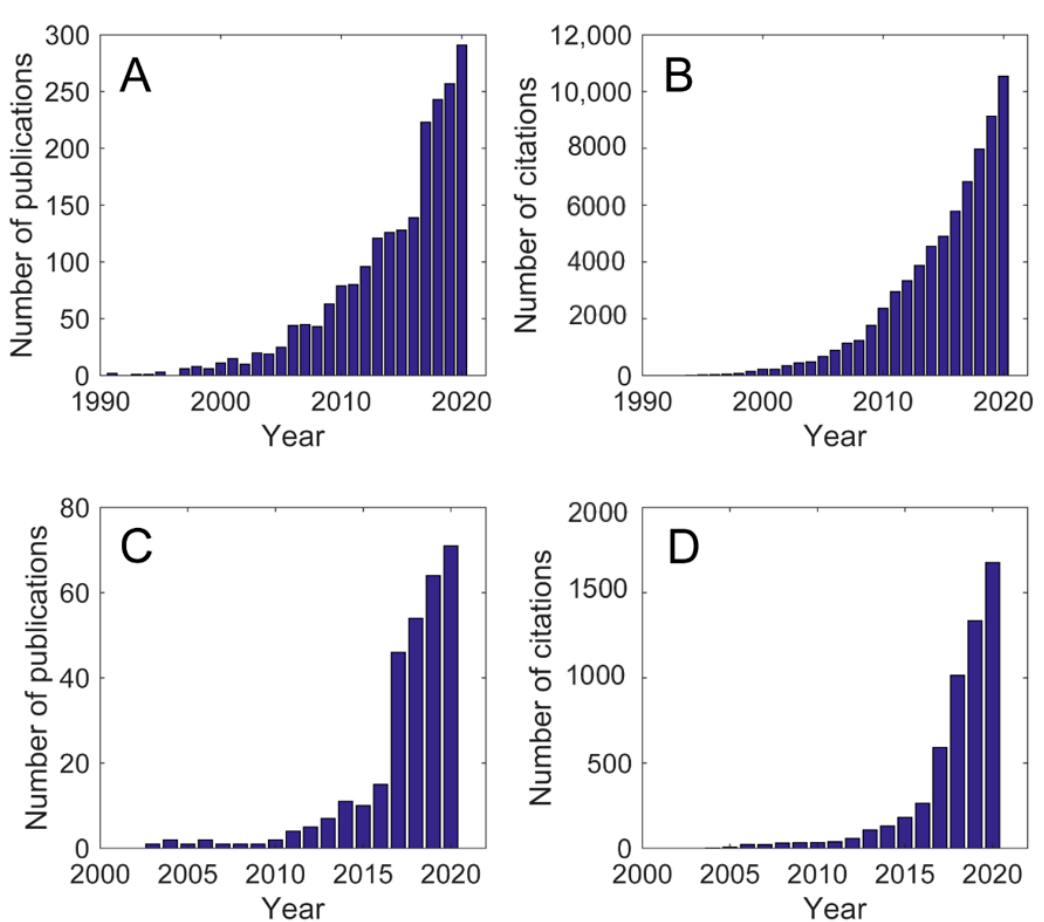
Figure 1. A summary showing an increasing interest in the concept of landscape system connectivity during the last decades (Web of Science Core Collection search was conducted on the title, abstract and keywords, within the timespan of 1900–2020). ( A ) number of publications focusing on connectivity: this search considers landscape connectivity, a term often used in ecology (search terms “landscape connectivity” OR “sediment connectivity” OR “geomorphic connectivity”); ( B ) number of citations (same search terms as in A); ( C ) number of publications specifically focusing on geomorphology/geosciences (search terms “sediment connectivity” OR “geomorphic connectivity”); ( D ) number of citations (same search terms as in ( C )).